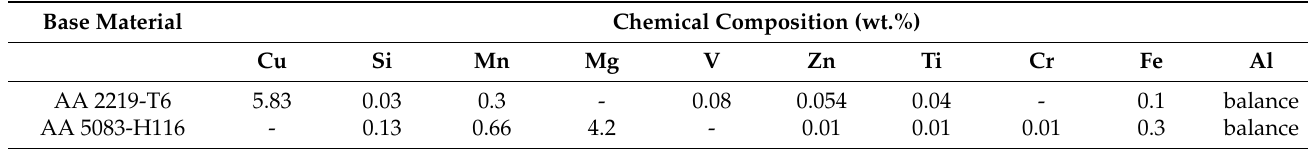
Table 1. Chemical composition of base materials.